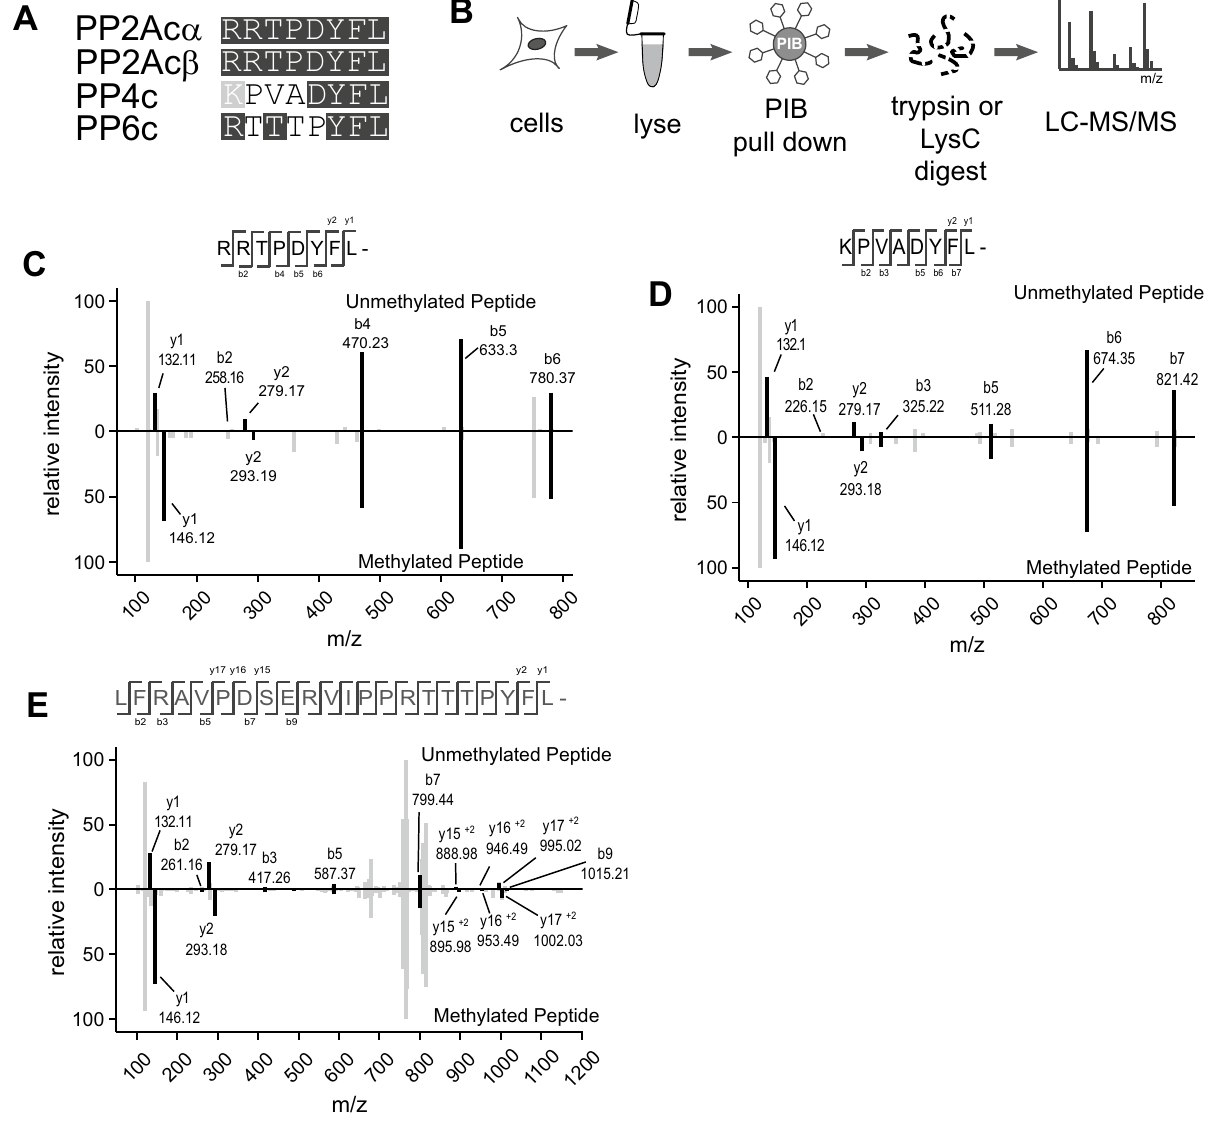
Figure 1. MS2 ion spectra of methylated and unmethylated C-terminal peptides for PP2Acα/β, PP4c, and PP6.c. ( A ) Alignment of the last eight amino acids of the catalytic subunits of the PP2A, PP4, and PP6. ( B ) Phosphatase inhibitor bead (PIB) pulldown workflow. Cells were lysed. lysates and incubated with PIBs, elutes were digested overnight with either trypsin or LysC and analyzed using LC–MS/MS. ( C - E ) MS2 ion spectra of the C-terminal peptides for PP2Acα/β, B, PP4c, and PP6c. The unmethylated peptides are shown on the top half of each plot, and the methylated peptide is inverted on the bottom. Ions corresponding to the indicated peptide are shown in black, others are shown in